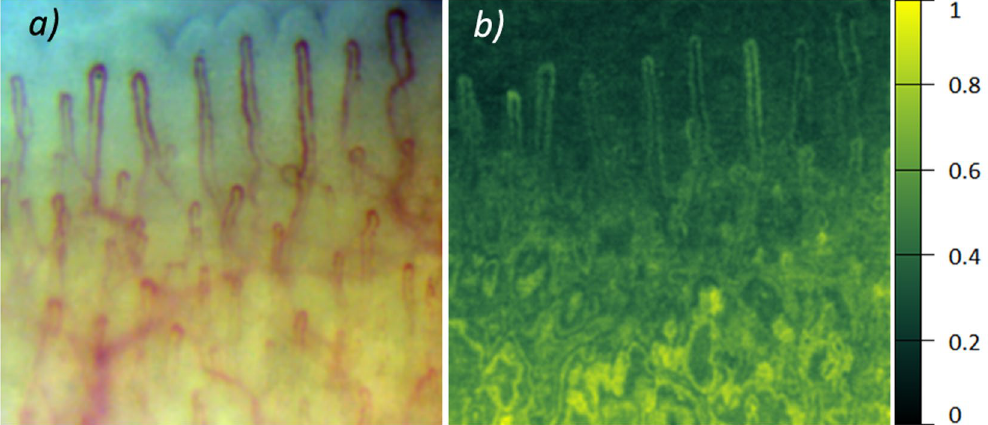
Figure 5. Mapping the amplitude of PPG waveform. ( a ) Microscopic image of capillaries. ( b ) Spatial distribution of the PPG-signal amplitude calculated for the green channel of the image. The color scale in the right side shows the PPG-signal amplitude in arbitrary